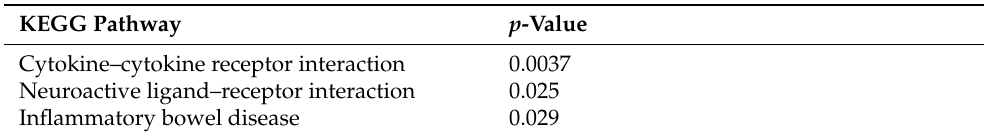
Table 3. Neuronal gene and its function selected by integration analysis. 244